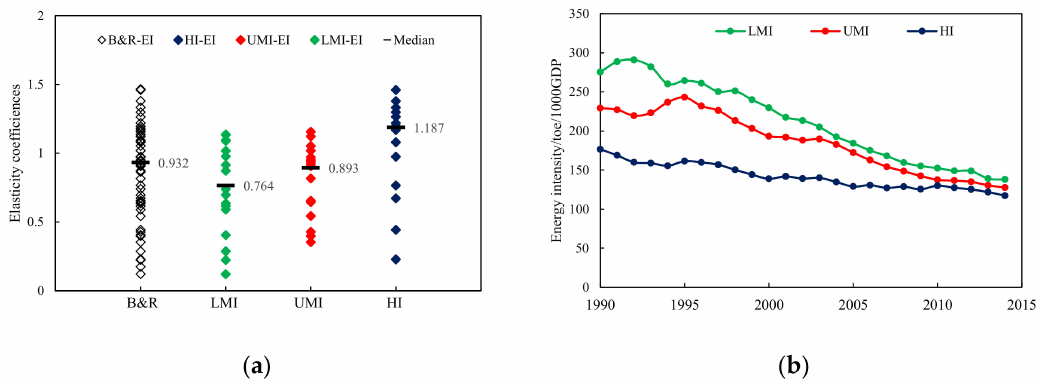
Figure 3. The elasticity coefficiences of energy intensity and its changes in different income groups: ( a ) The elasticity coefficiences of energy intensity in three income groups; ( b ) The changes in the energy intensity of three income groups from